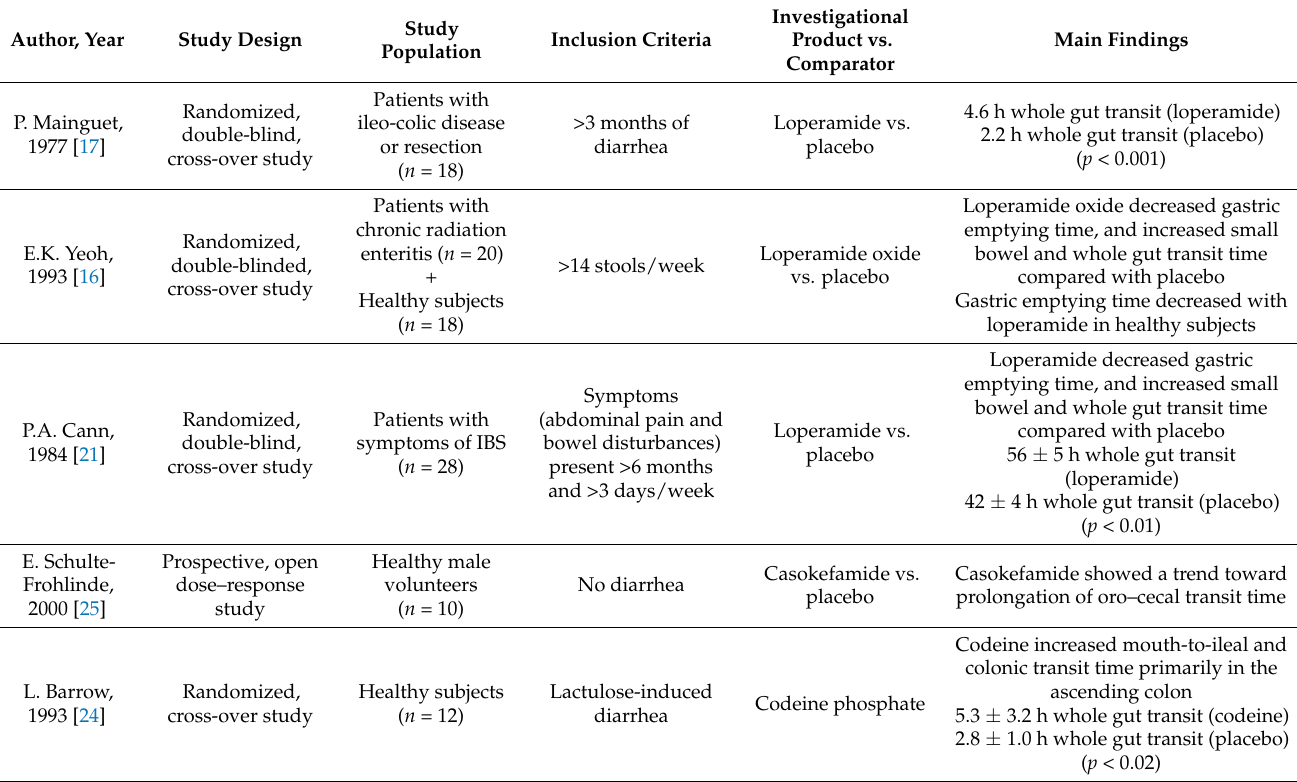
Table 3. Transit time